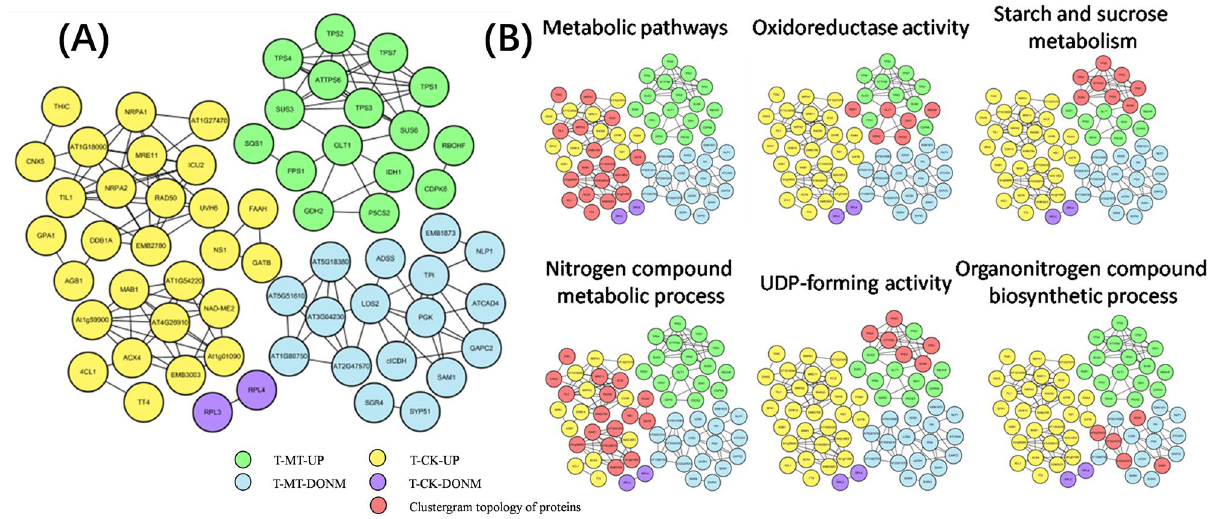
Figure 8. ( A ) Proteins from genes upregulated in T-MT (green), proteins from genes downregulated in T-MT (blue), proteins from genes upregulated in T-CK (yellow), and proteins from genes downregulated in T-CK (purple) identify a rich network of known and previously unknown proteins. Node titles correspond to the gene name, and connections represent interactions between proteins. ( B ) Clustergram topology of proteins (red) in selected functional categories or KEGG